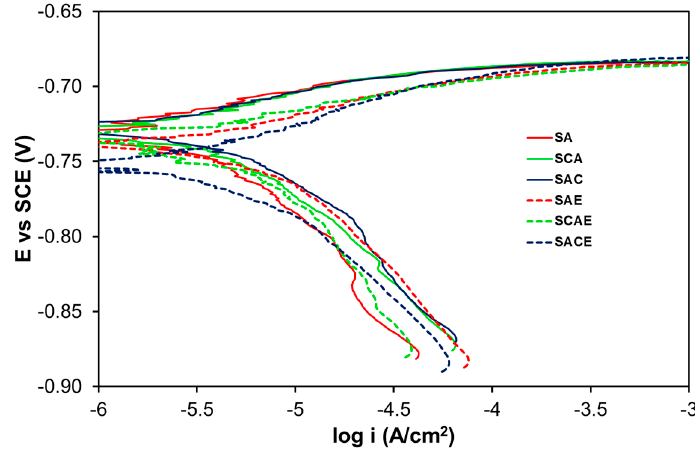
Figure 3. Tafel plots of the studied samples in the aerated solution. Table 3. Average kinetic values of the different AA6012 samples obtained from Tafel plots in aerated solution.